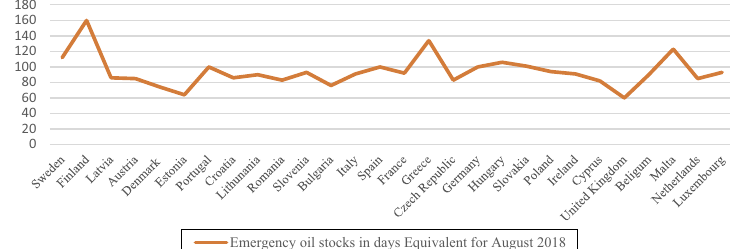
Figure 8. Emergency oil